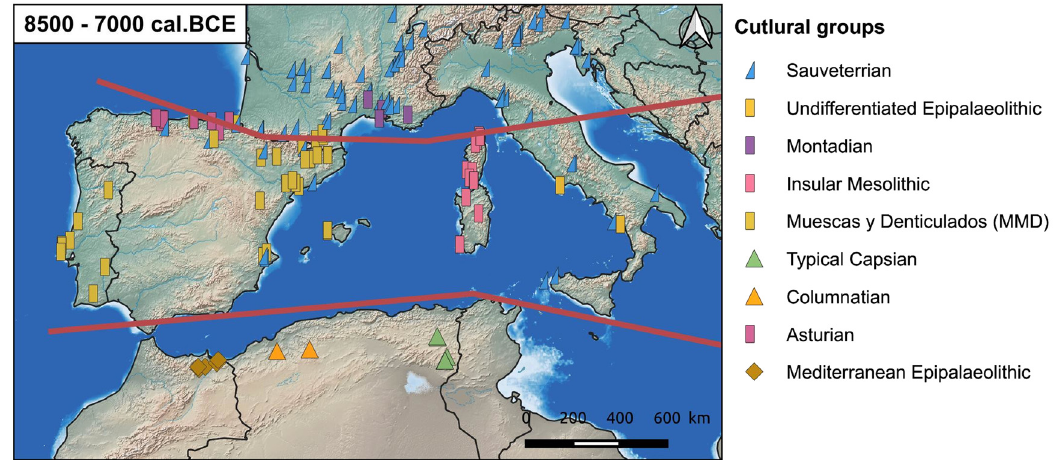
Figure 7: Lines showing the tripartition of the Western Mediterranean basin between 8500 and 7000 cal. BCE according to the lithic